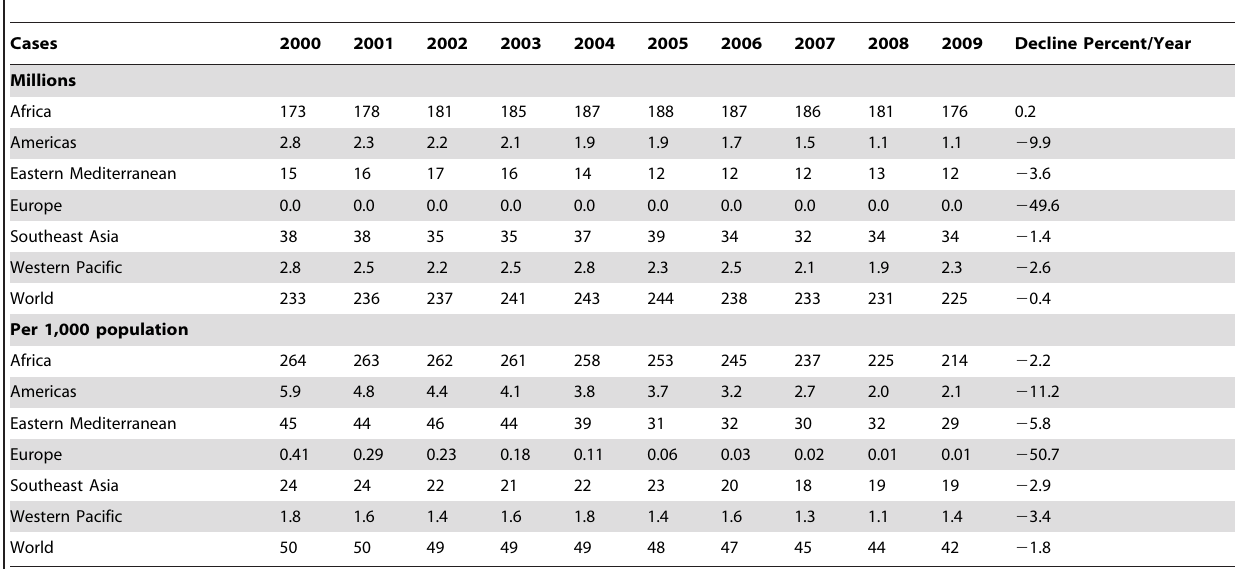
Table 6. Trends in malaria incidence by WHO region and globally, 2000–2009, presented as total number of cases (millions, upper panel) and cases per 1,000 population (lower